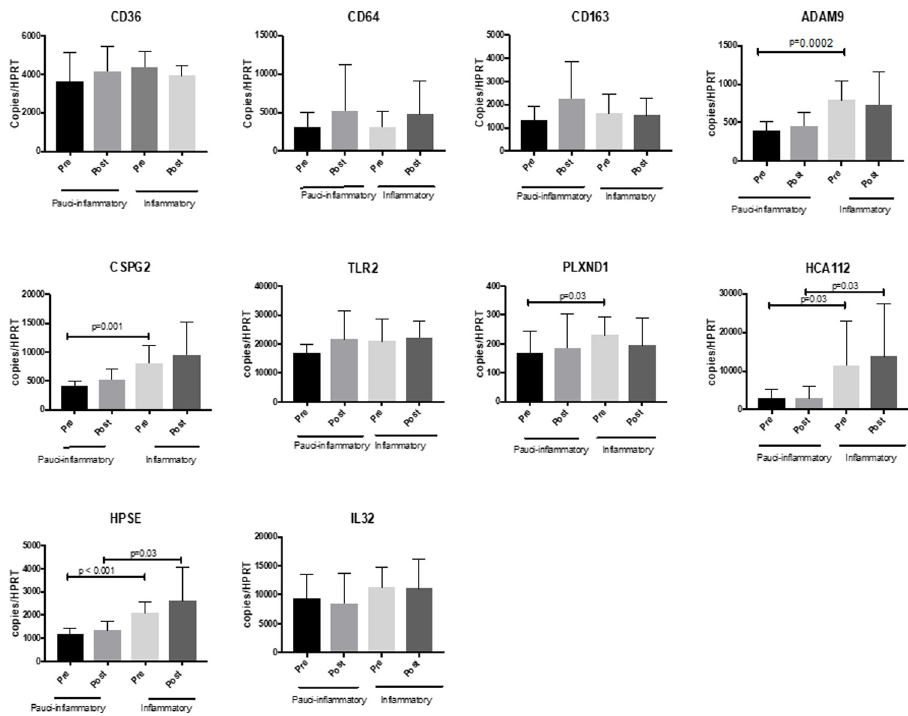
Fig 6. Whole blood gene expression stratifies AZLI treatment groups before treatment initiation, based upon hierarchical clustering. Pauci-inflammatory and inflammatory clusters are classified based on Pre-treatment dendrogram as shown in Fig 5, with expression of panel genes for each group. Again, columns depict means ( ± SD) relative to the detection of housekeeping gene HPRT and differences analyzed by paired t-test and 2 sample t-test following log